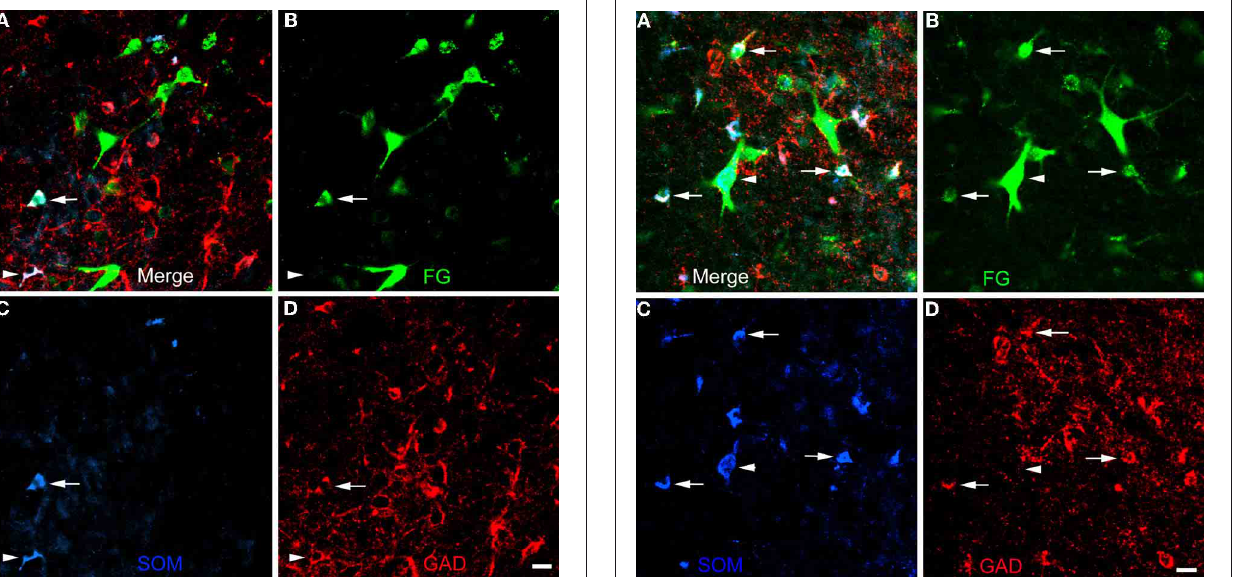
FIGURE 9 | Photomicrographs of neurons in the external capsule laterally adjacent to the ventral basolateral nucleus at bregma level-2.8 in a section triple-labeled for FG (green), SOM (blue), and GAD (red). (A) Merged image visualizing all three channels. Arrows indicate 3 of 6 neurons in this field triple-labeled for FG/SOM/GAD + (white). Arrowhead indicates a GAD-negative FG/SOM + neuron (blue-green). The locations of the same neurons are indicated by identical arrows and arrowheads in B , C , and D . (B) Green channel image showing FG + neurons. (C) Blue channel image showing SOM + neurons. (D) Red channel image showing GAD + neurons. Scale bar in D = 20 µ m (also applies to A , B , and C ).